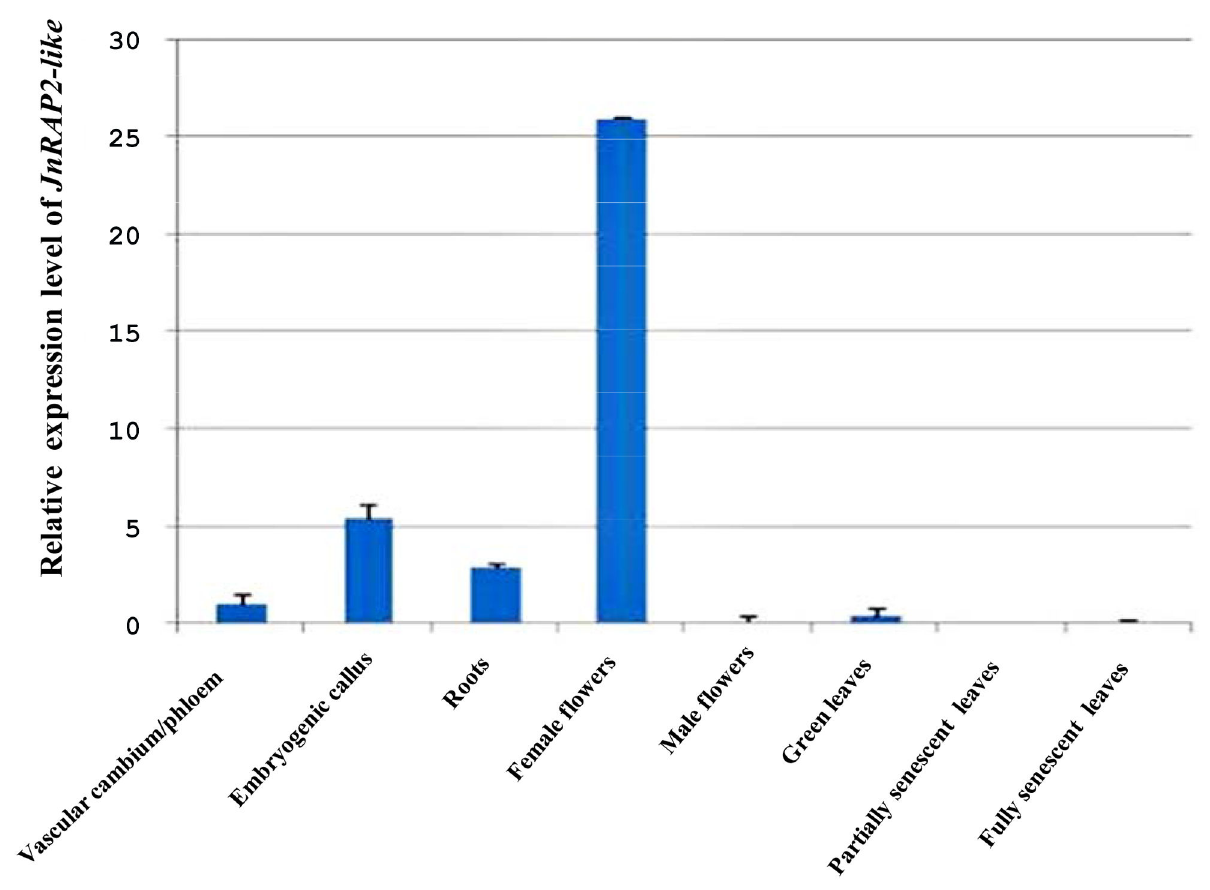
Figure 5. Transcript abundance of JnRAP2-like transcription factor in tissues of black walnut. Quantification of JnRAP2-like expression in black walnut tissues using real-time PCR. 18S rRNA was used as a standard. The fold changes were quantified and analyzed by the comparative C method. Values are the means ± SE for two biological T